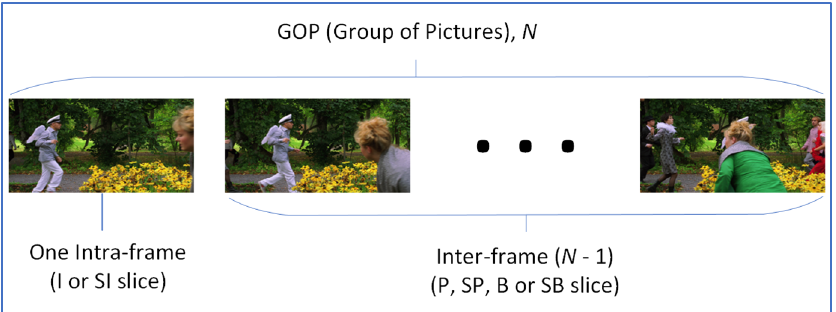
Figure 2. GOP in compressed